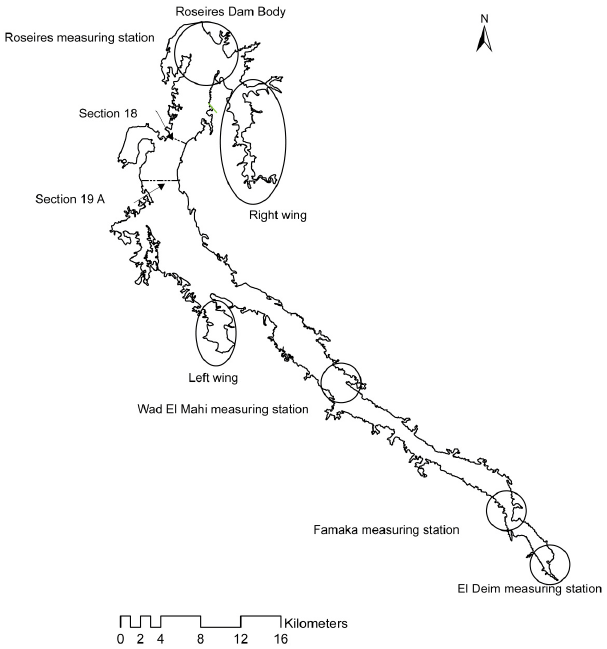
Figure 2. Measurement stations and the areas (circled) that are not covered by the surveys of 1985 and 1992. The thick black line rep- Fig. 2. Measurement stations and the areas (circled) that are not covered by the resents the contour of the reservoir at an elevation of 481ma.s.l. surveys of 1985 and 1992. The thick black line represents the contour of the reservoir (irrigation at an elevation of 481m.a.s.l. (Irrigation Datum).